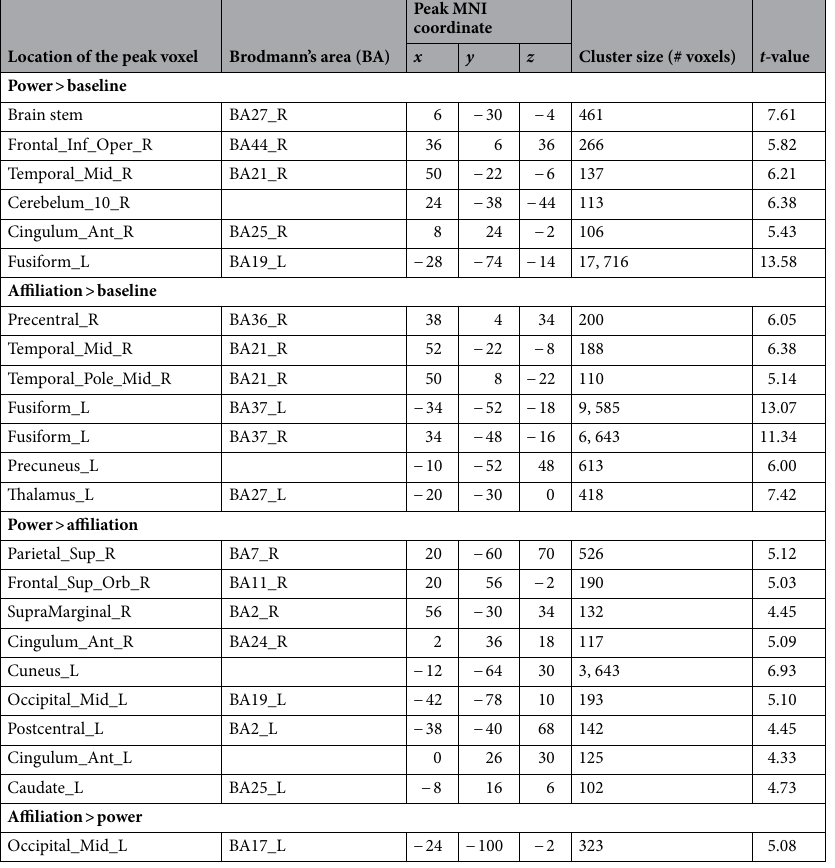
Table 2. Brain clusters showing significant differences in activation corresponding to the power versus baseline, affiliation versus baseline, power versus affiliation, and affiliation versus power